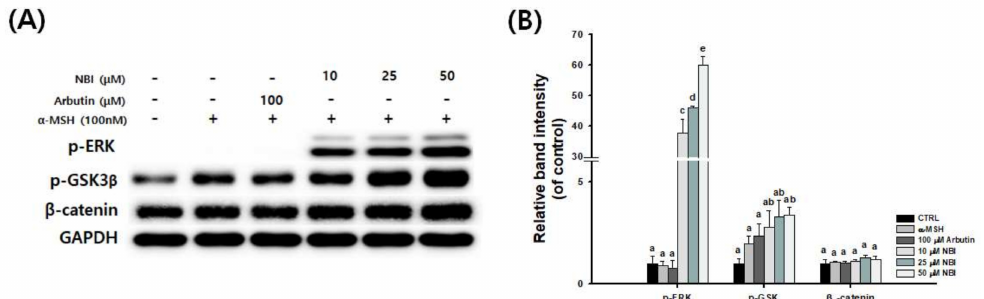
Figure 7. E ff ect of NBI on GSK3 β - and ERK-dependent signaling in B16F10 cells. B16F10 cells were treated with α -MSH and NBI at the indicated concentration. ( A ) p-ERK, p-GSK, and β -catenin protein expression levels, and ( B ) The graph indicates the expression level against GAPDH expression level. Data are presented as mean ± SD. Values with di ff erent letters (a, b, c, d, e) are significantly di ff erent one from another (one-way ANOVA followed by Tukey’s multiple range test, p <